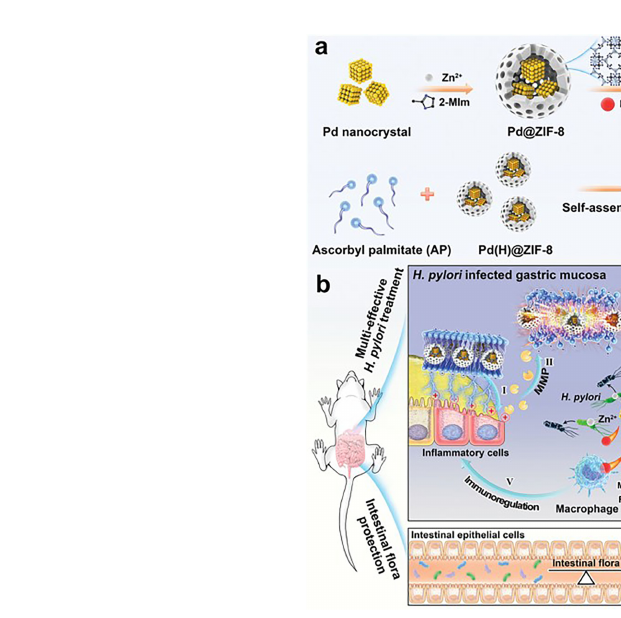
FIGURE 3 | Helicobacter pylori treatment. (A, B) Schematic diagram showing the process of H pylori and restoring impaired gastric mucosa (75). Copyright 2021, WILEY-VCH.